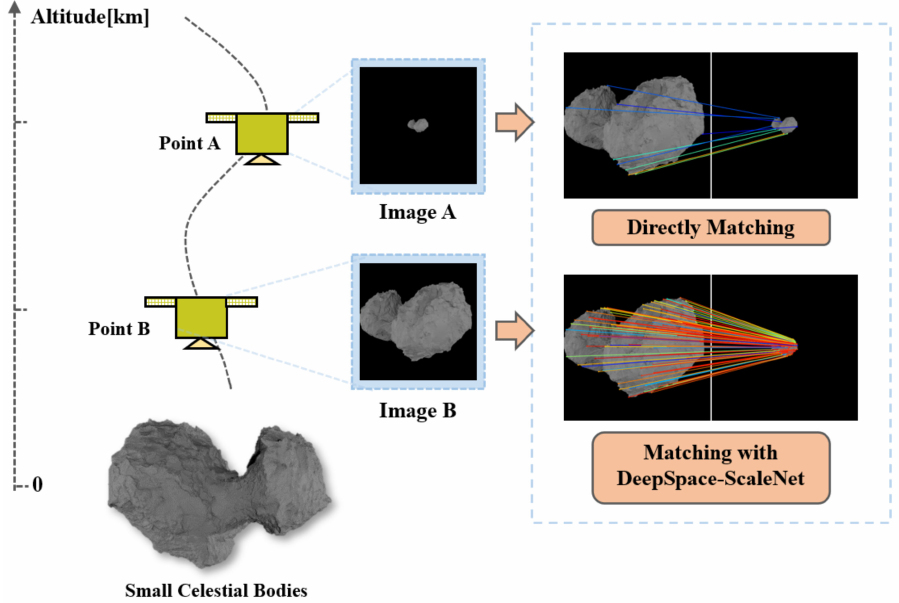
Figure 1. Schematic Diagram Of Image Matching With DeepSpace-ScaleNet During SCB